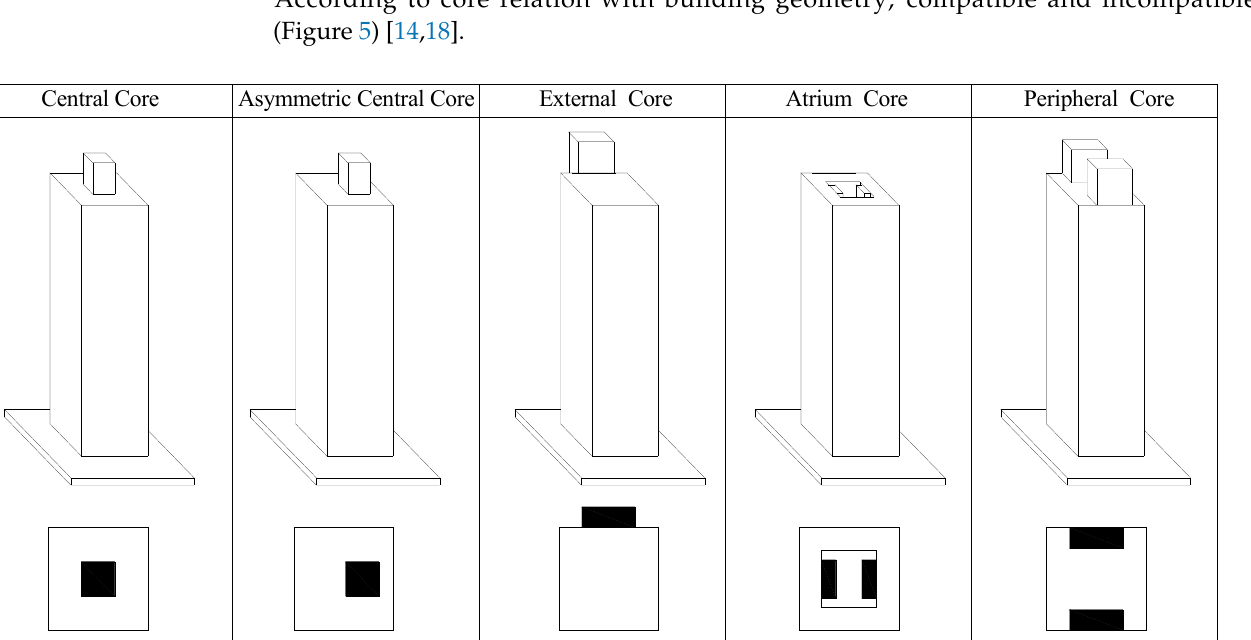
Table 3. Classification of selected tall buildings by core planning.